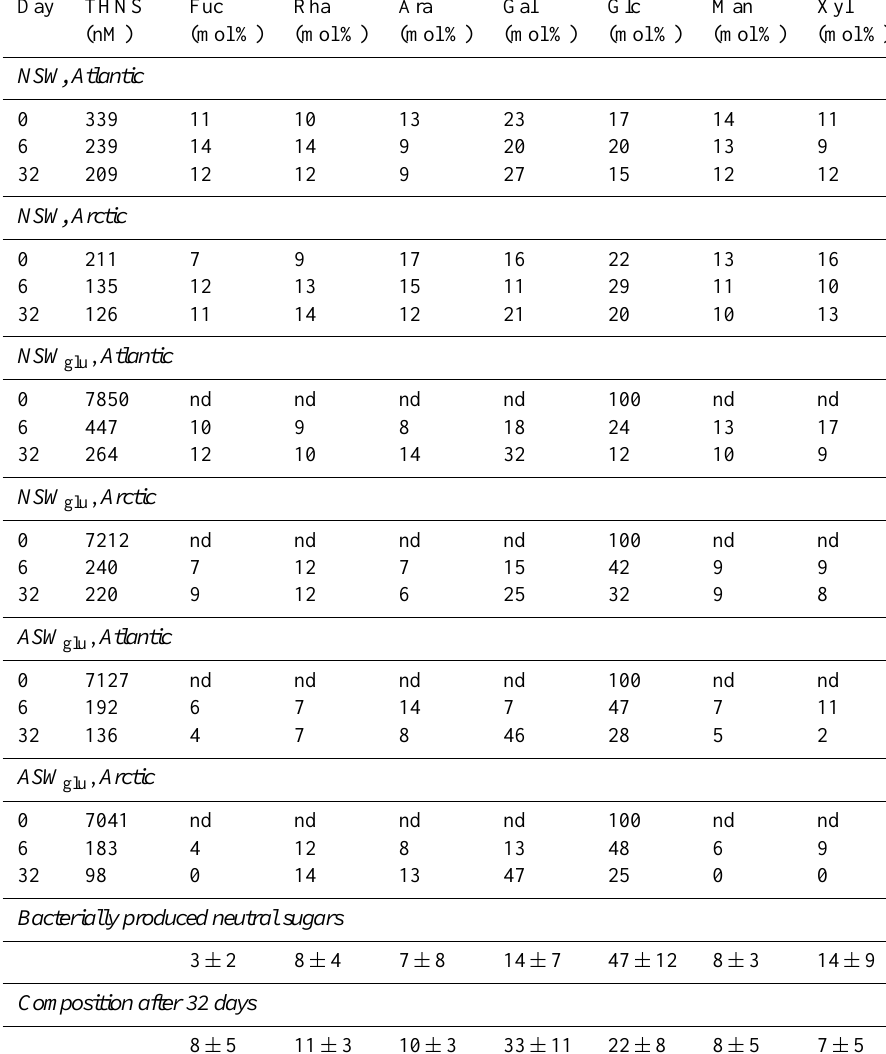
Table 1. Molecular composition of neutral sugars in the six different treatments during the incubations. The neutral sugars produced by bacteria in the glucose-enriched samples during the first 6 days ( n = 4; see “Methods” for an explanation of the calculations) and the neutral sugars remaining after 32 days ( n = 6) are given as means and standard deviations. nd: not